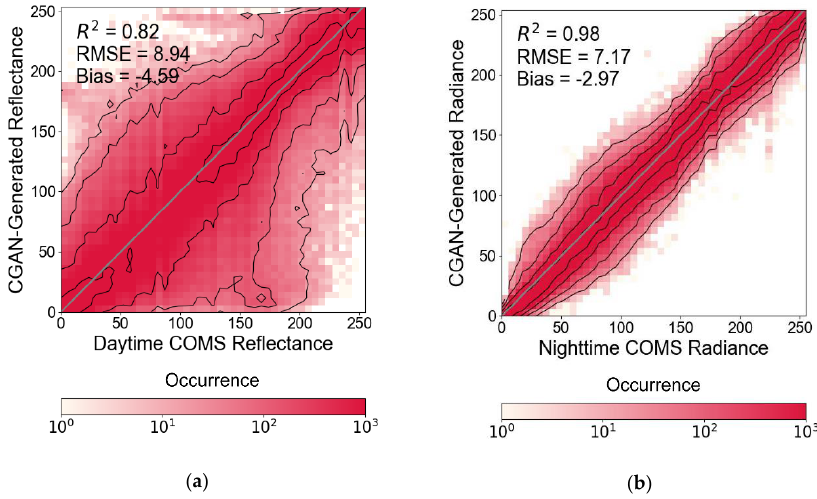
January, 16:00 UTC (nighttime) at the COMS 3.75 μm band. The bias, root-mean-square-error (RMSE),